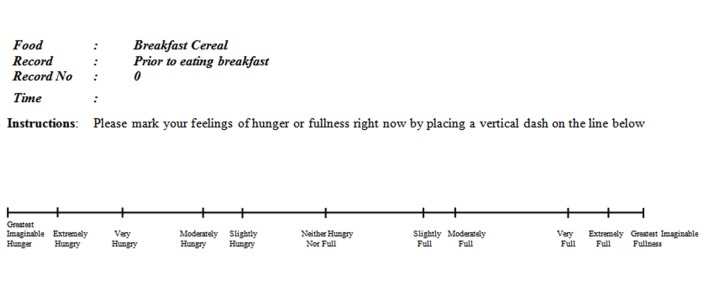
Labelled magnitude satiety scale (LMS).